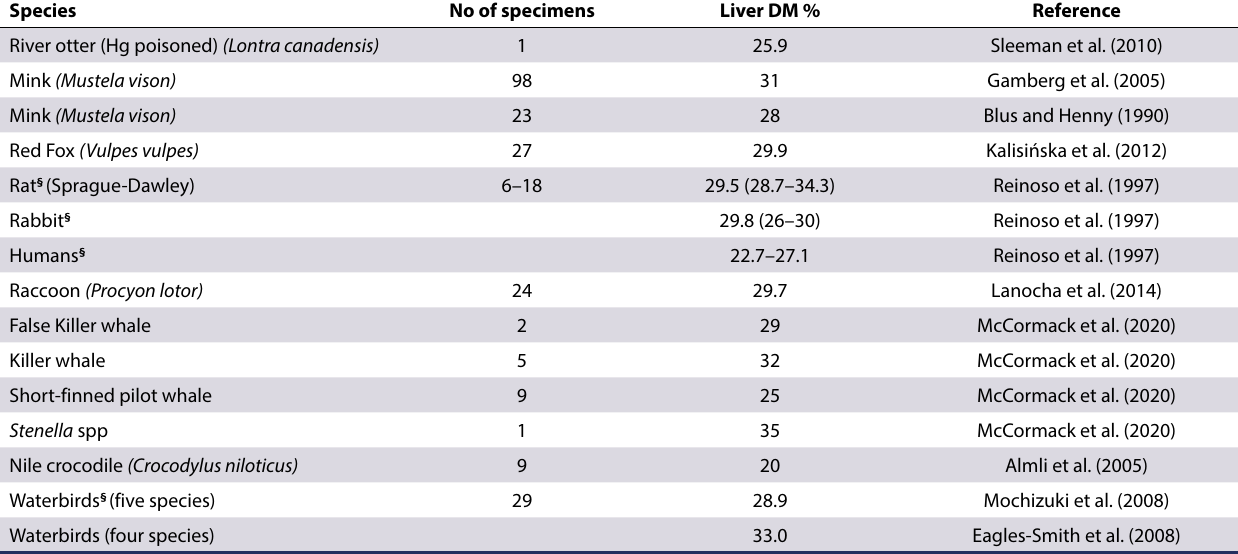
Table VI: Percentage dry matter (DM) in the livers of different species of mammals, the Nile crocodile and waterbird species Species No of specimens Liver DM